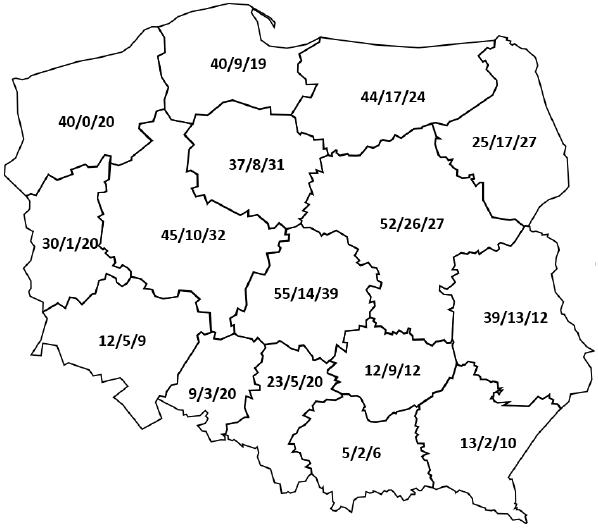
Figure 1. Number of pairs of soil-plant samples taken in Polish provinces: wheat/maize/rape. Wheat was sampled from an area of 1 m 2 , maize was sampled from an area of 8 m 2 and rape was sampled from an area of 4 m 2 . Whole shoots of wheat were cut 2 cm above the ground at the beginning of stem elongation stage (BBCH 30/31). The shoots of the of 25–30 cm (BBCH 14–15); and rape, in the period from the beginning of the main stem elongation stage to the appearance of the first internode (BBCH 30/31) [22]. Each wheat sample consisted of a minimum 80 shoots, and maize and rape of a minimum of 20